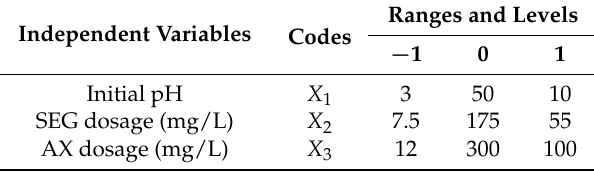
Table 1. Experimental range and levels of the independent variables. SEG: seaweed glue. Independent Variables